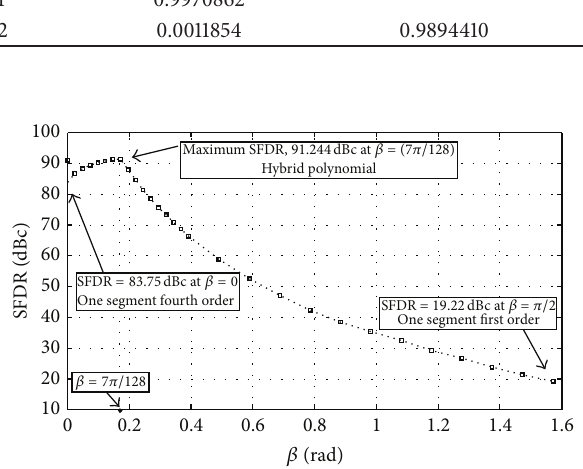
Figure 4: Hybrid polynomial SFDR with nondigitized optimal coefficients.